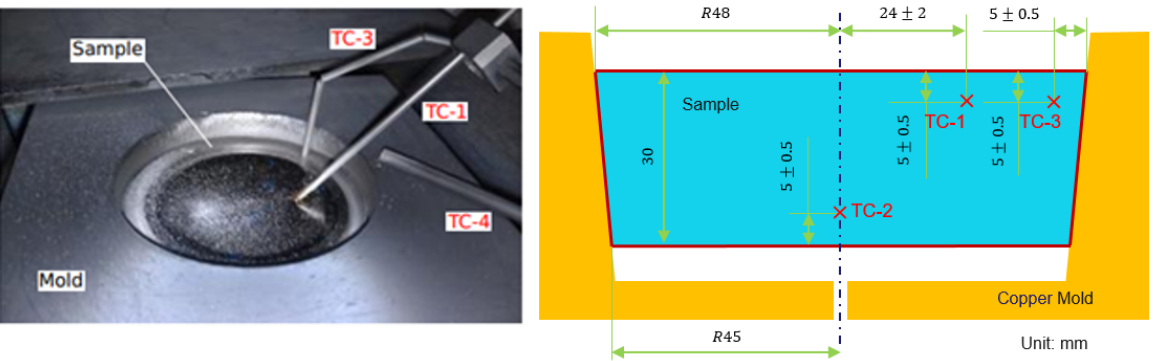
Figure 4. Experimental setup and schematic of the locations of the thermocouples in the EBBM model [14].